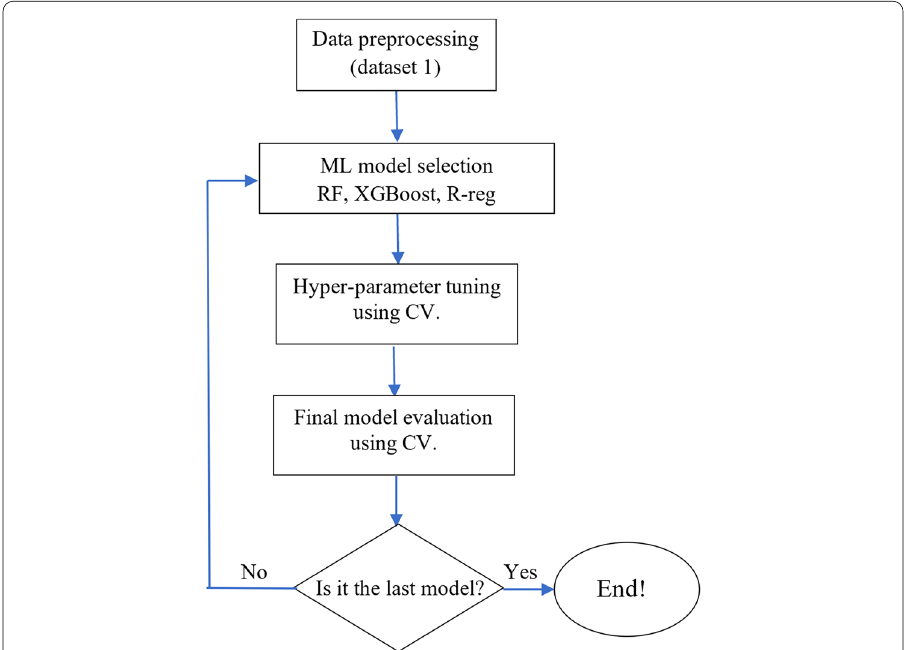
Fig. 3 Developed machine learning